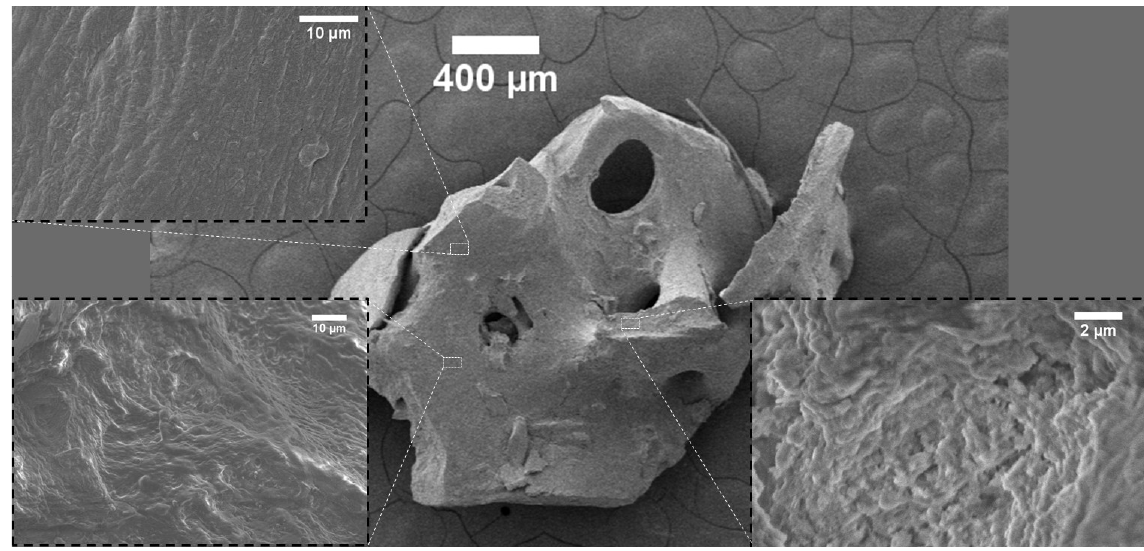
Figure 1. SEM images of Allograft-Zimmer.